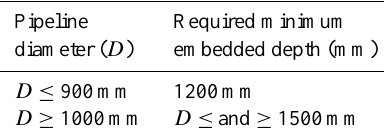
Table 2. Required minimum embedded depth for buried pipeline as loading is applied to ground surface (Ministry of Land, Transport, and Maritime Affairs, 2010).